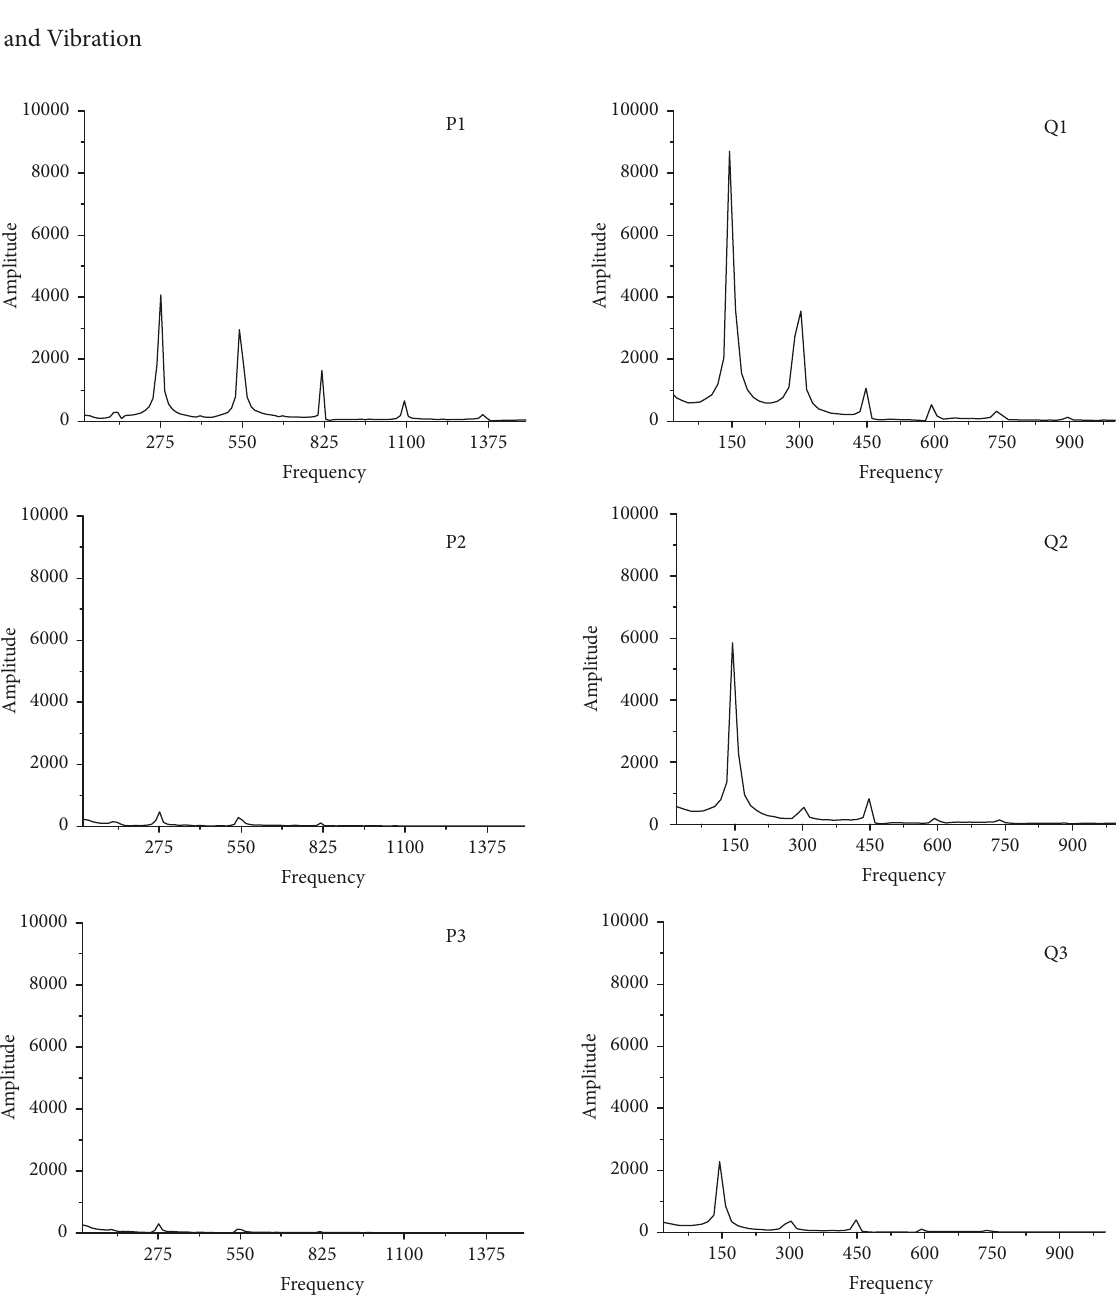
Figure 8: Pressure pulsation of monitors P1, P2, P3, Q1, Q2, and